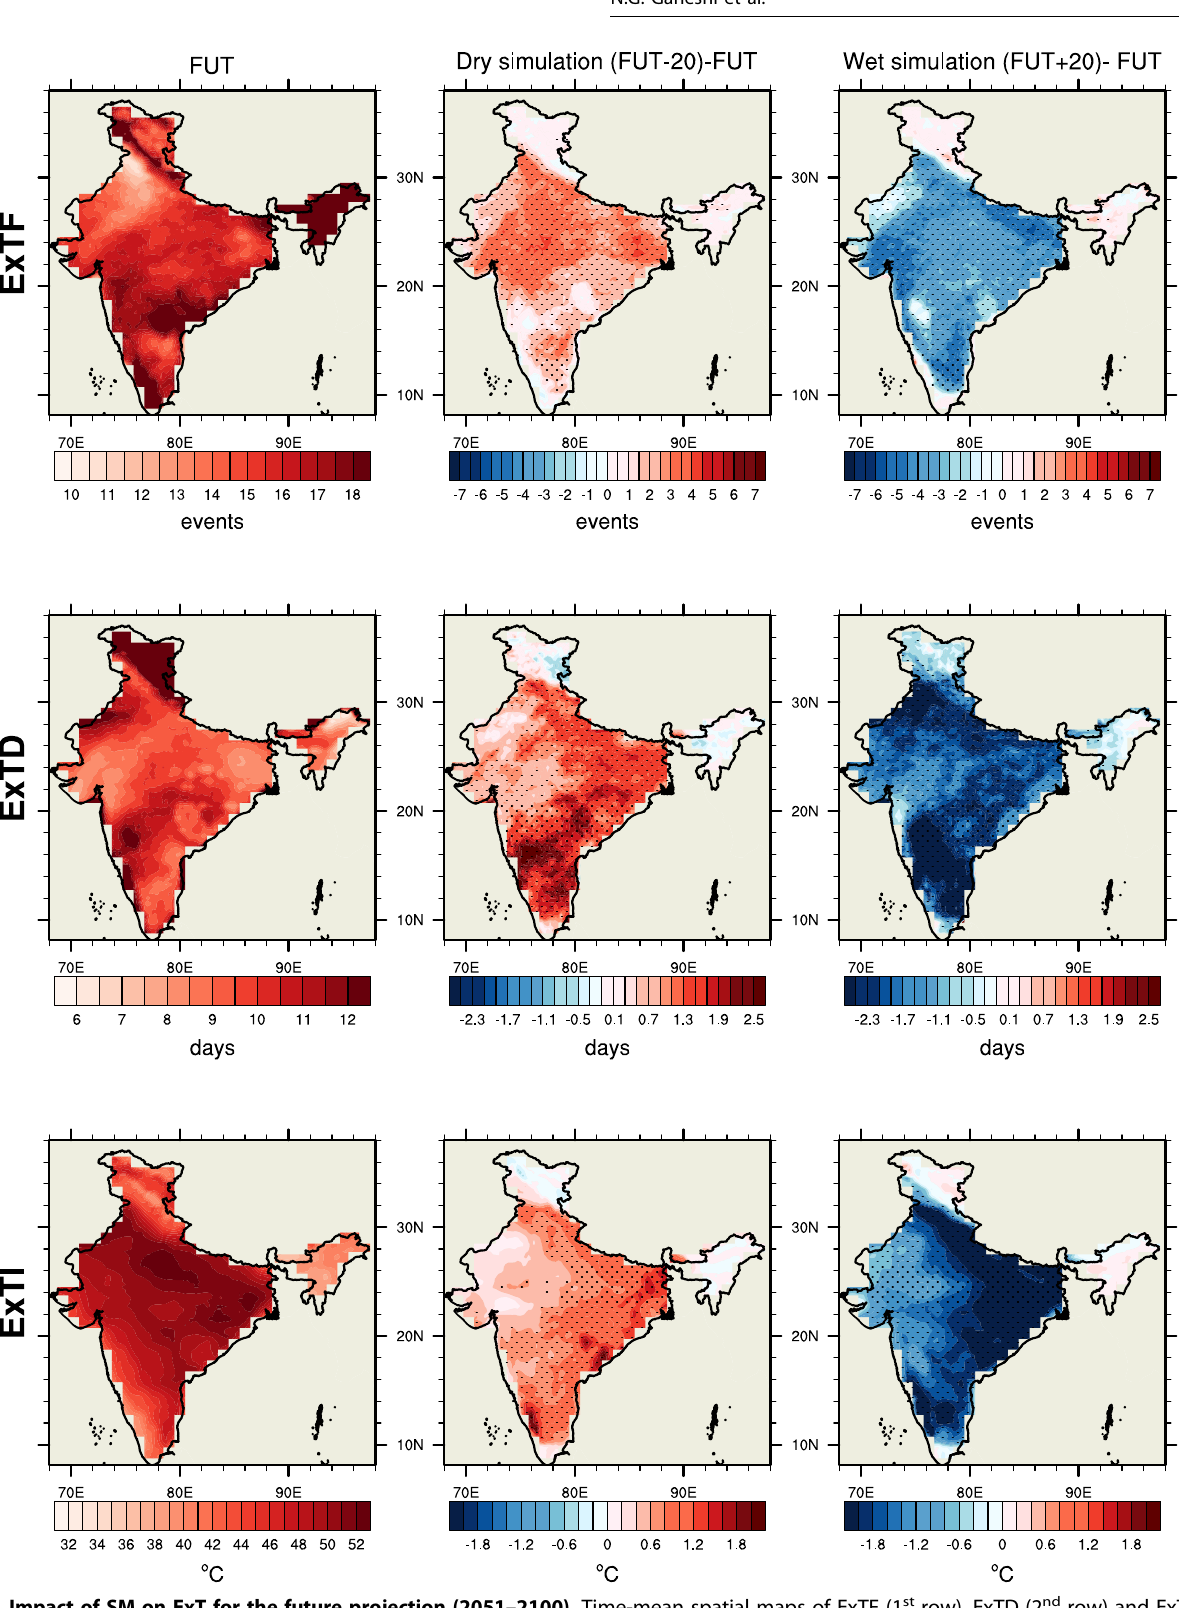
Fig. 6 Impact of SM on ExT for the future projection (2051 – 2100). Time-mean spatial maps of ExTF (1 st row), ExTD (2 nd row) and ExTI (3 rd row) from the FUT experiment (1 st column), difference between the FUT-20 and FUT experiments (2 nd column), and the difference between FUT + 20 and FUT experiment (3 rd column) during the future climate (2051 – 2100). Stippling in Figures indicate the regions where difference between the FUT-20/FUT + 20 and FUT experiment is signi fi cant at 95% con fi dence